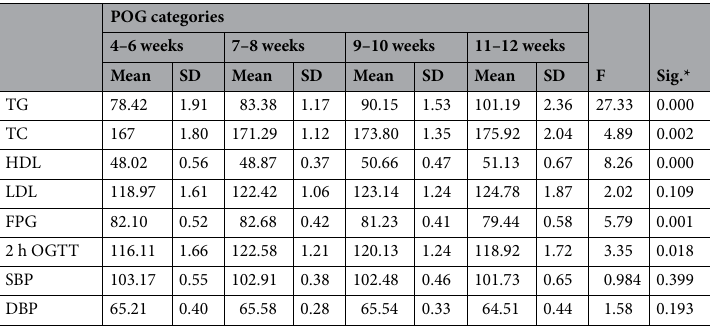
Table 3. Change of biochemical parameters and blood pressure values among POG categories among 2682 first trimester pregnant women. POG period of gestation, SD standard deviation, TG triglycerides, TC total cholesterol, HDL high density lipoproteins, LDL low density lipoproteins, FPG fasting plasma glucose, 2 h OGTT 2 hour oral glucose tolerance test, SBP systolic blood pressure, DBP diastolic blood